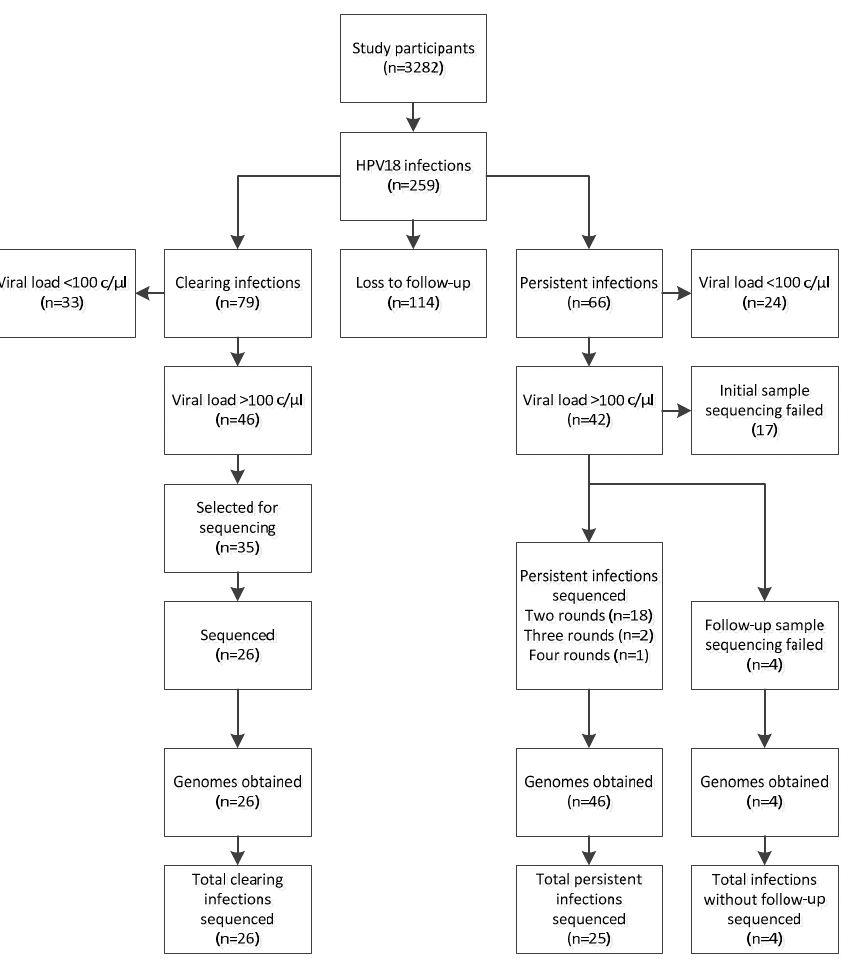
Figure 1. Schematic overview human papillomavirus 18 (HPV18) infections in this study, including loss to follow-up and selections made for persistent and clearing HPV18 infections. Table 1. General characteristics of study participants with human papillomavirus 18 positive results. Subsets were not found to be significantly different from the complete study population with regard to age, C. trachomatis status and ethnicity ( p > 0.05).